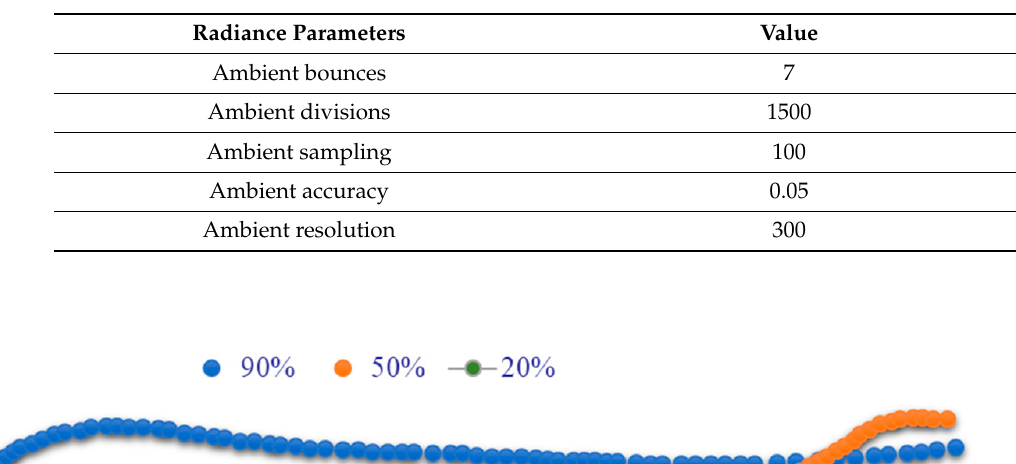
Table 2. Radiance parameters used in daylighting simulation.